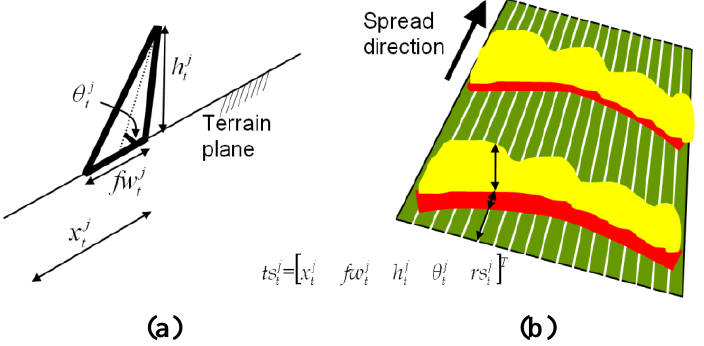
Figure 9. (a) Schematic geometry of a fire-front triangle. (b) Diagram representing the state of the fire front as the state of a series of equally-spaced fire-front